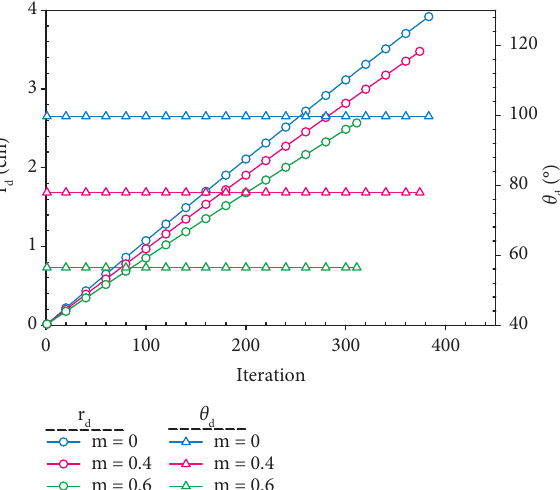
Figure 11: Te evolution of the breakout depth and width, from breakout initiation to stability.